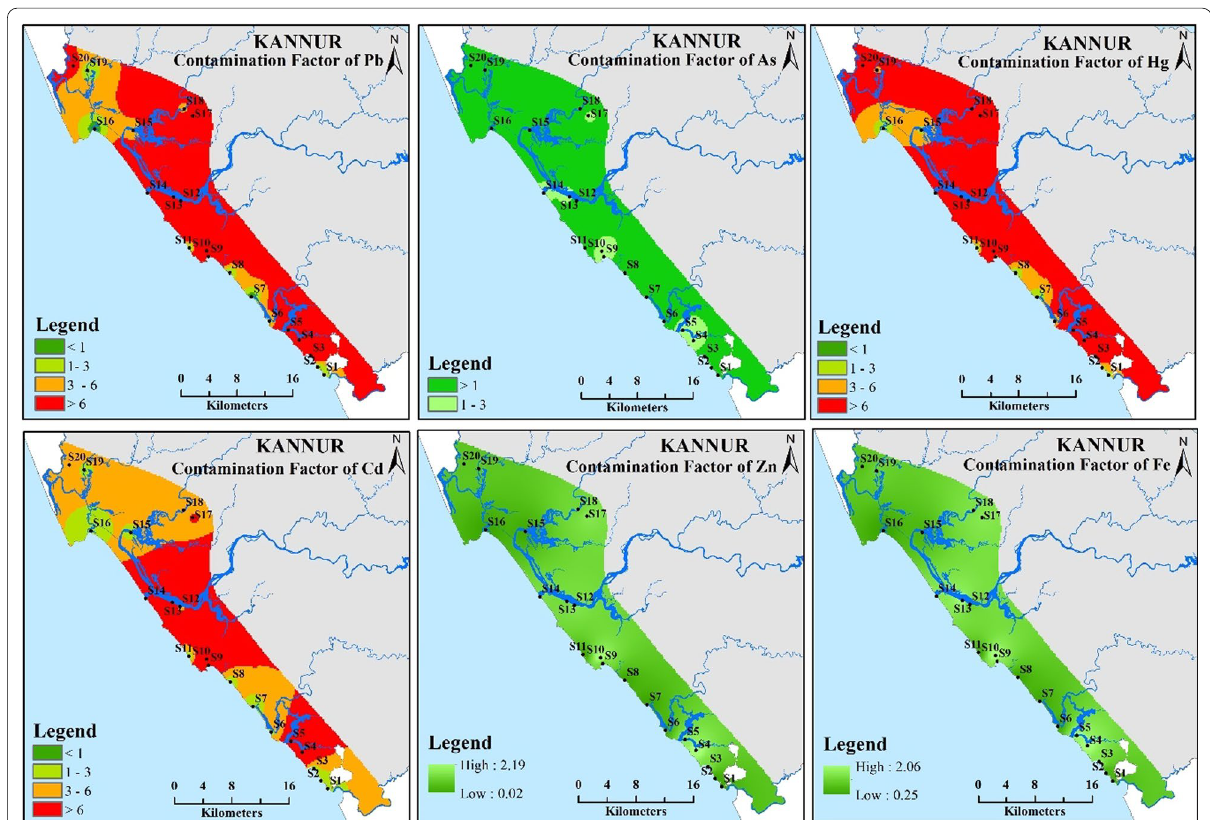
Fig. 5 Spatial distribution of contamination factor of heavy